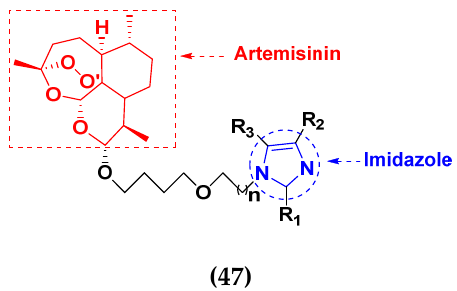
Figure 53. Structure of imidazole-based artemisinin hybrid derivatives ( 47 ). Table 40. In vitro cytotoxic activities of imidazole ‐ based artemisinin hybrid compounds 47 ( a – e ). CompounNo.